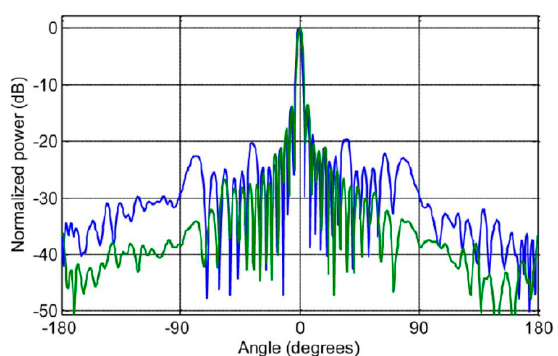
Figure 19. Measured radiation pattern of the antenna shown in Figure 18 [61]: E-plane (blue line); H-plane (green line).